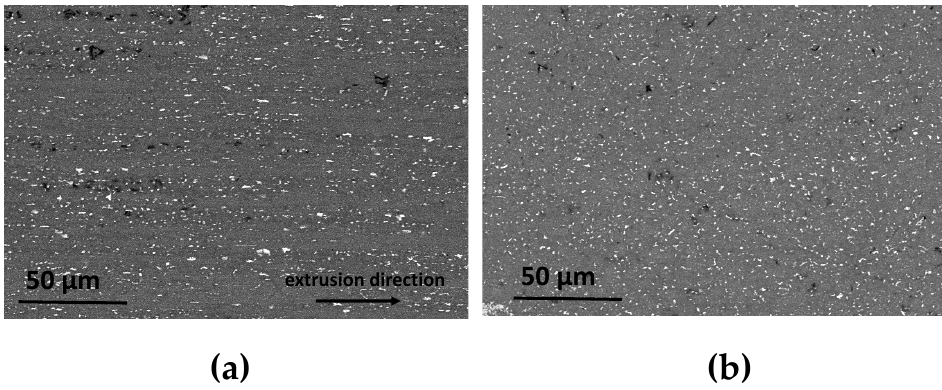
Figure 15. SEM images (BSE mode) of longitudinal section ( a ) and cross-section ( b ) for bar obtained from HT compact by extrusion process (heat treatment at 525 °C, 1 h; extrusion at 525 °C). The hardness on the cross-section was 84 ± 5 HV 0.5 . This value is lower compared to that from GC extruded at the same extrusion temperature (102 ± 2 HV 0 . 5 ; see Table 3). Note